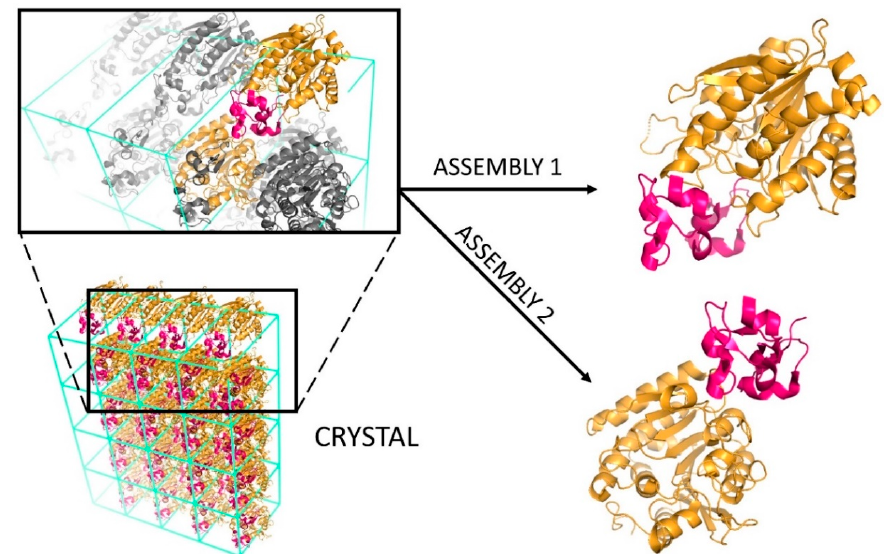
Figure 2. Schematic representation of the biological interface classification. In the lower left part of the figure, the crystal of the heterodimer between HLA class I histocompatibility antigen (in yellow) and beta-2-microglobulin (in dark pink) is reported (PDB code: 1ZLH [7]). Each unit cell of the crystal lattice contains two heterodimers. According to the architecture of this crystal, HLA can share two different interfaces with the beta-2-microglobulin: One formed with beta-2-microglobulin belonging to the same unit cell (assembly 1) and another formed with beta-2-microglobulin belonging to the adjacent unit cell (assembly 2).